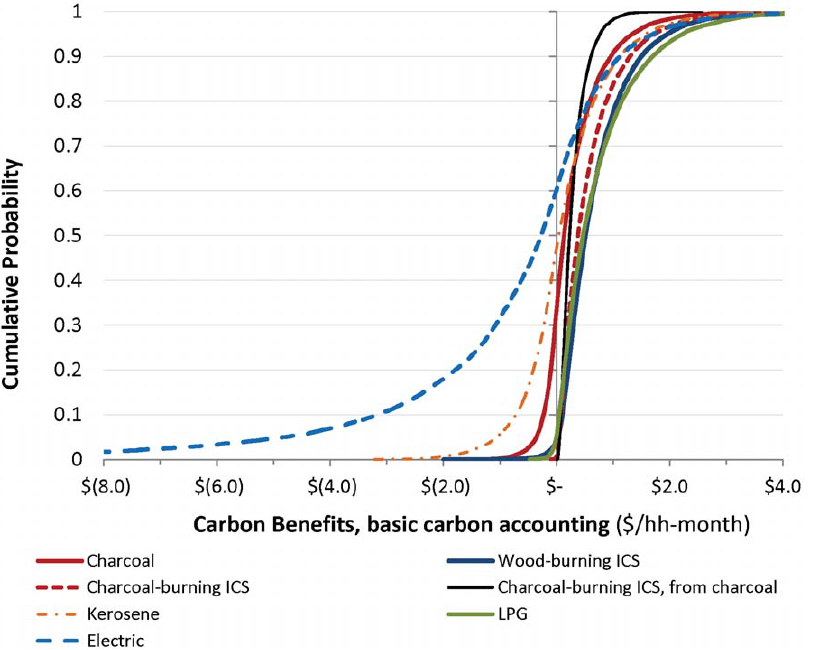
Figure 4. Carbon emissions benefits for different stove options, with UNFCC methodology accounting for emissions from CO 2 , CH 4 , and N 2 O. All are measured relative to traditional wood-burning stoves except for the move from the traditional to improved charcoal-burning stove.